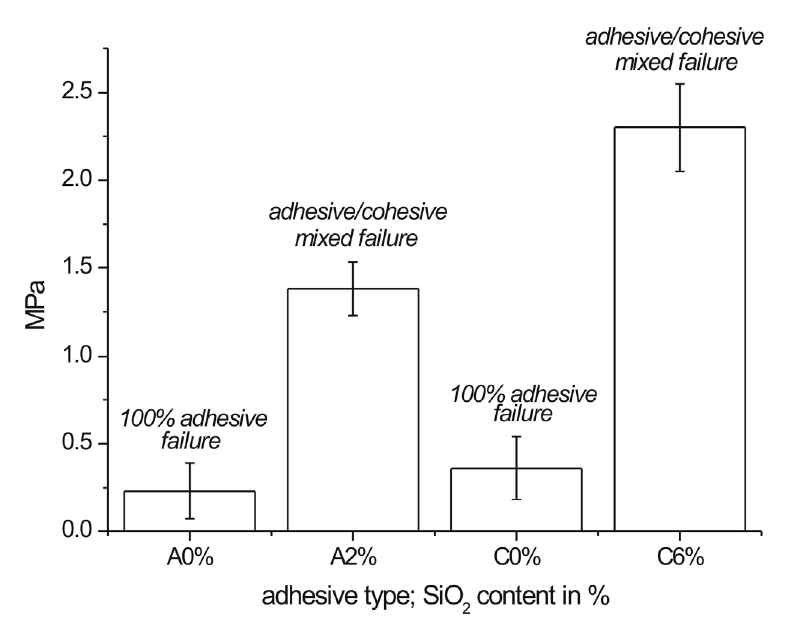
Figure 6. Bondline strength in pull-off tests performed on medium density fiberboard (MDF) veneered with 0.6-mm thick oak veneer.